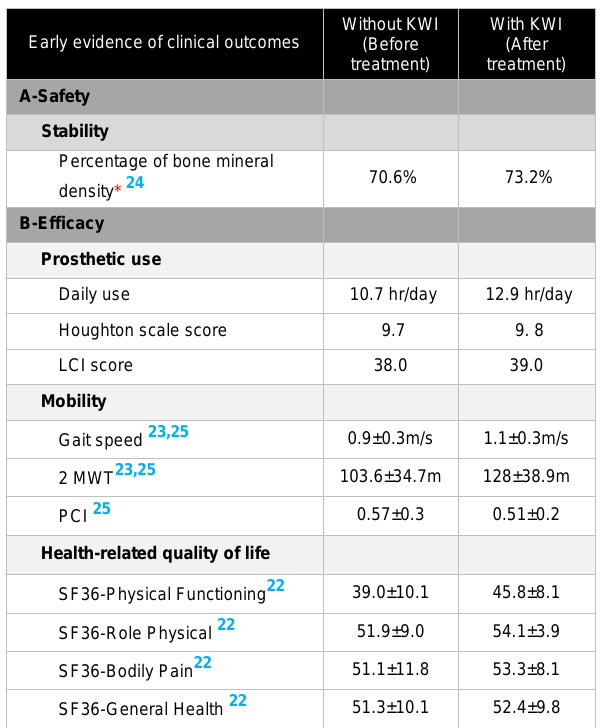
Table 1: Summary of clinical outcomes with and without Keep Walking Implant